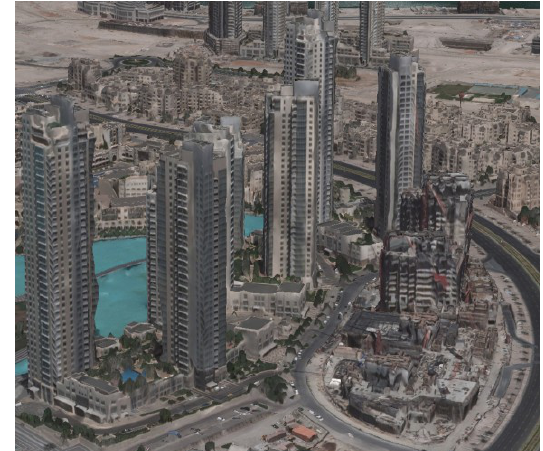
Figure 5. Textured Model Sample 1